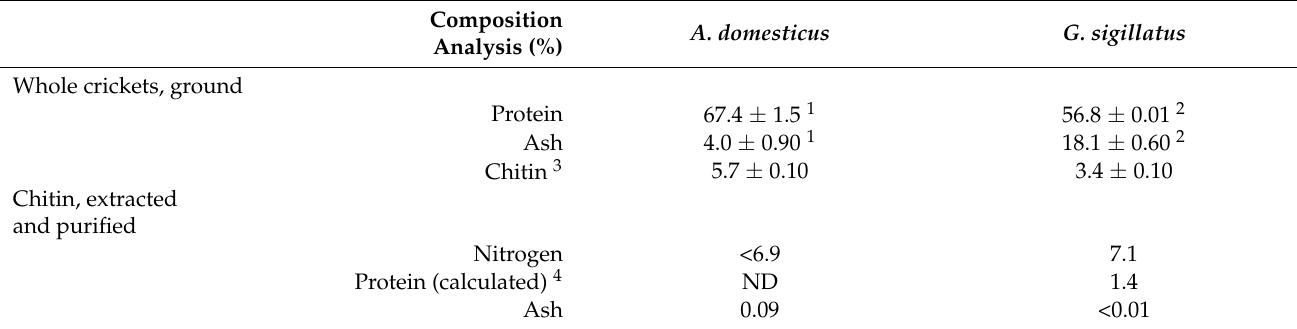
Table 1. Chitin composition and yield, after proteolysis and purification, with reference to whole